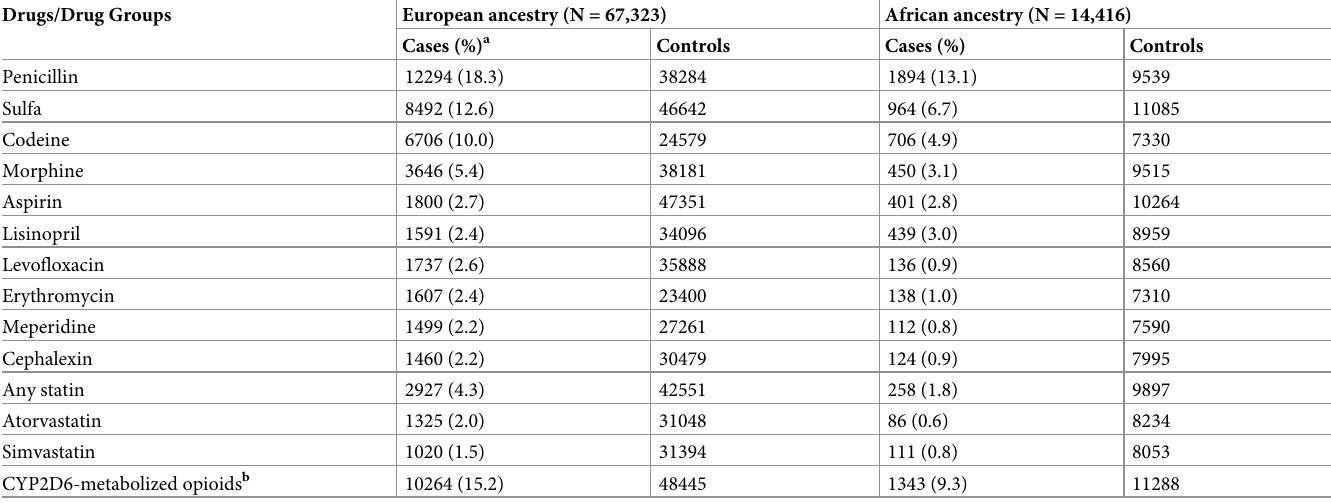
Table 2. Case and control counts for adverse drug reactions to 14 selected drugs or drug groups, stratified by self-reported ancestry. Drugs/Drug Groups